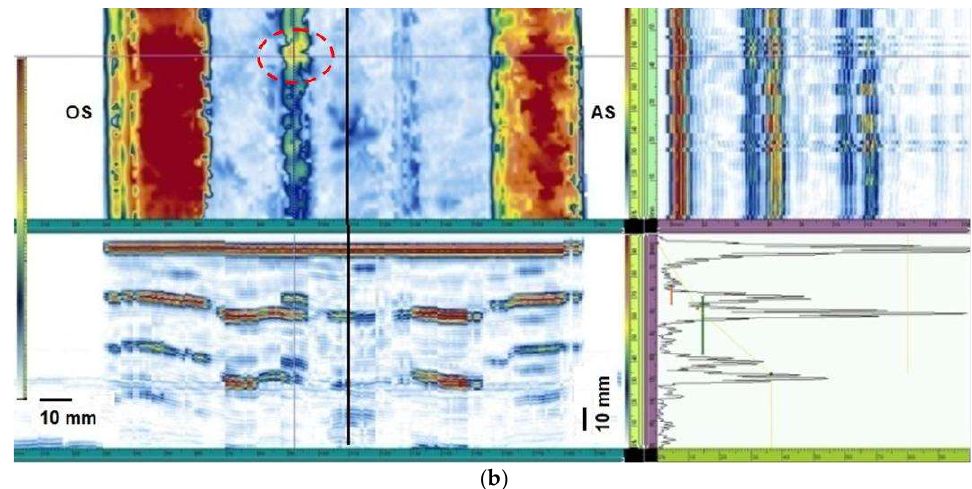
Figure 9. ( a ) Specimen 3 after delamination fracture; ( b ) ultrasonic testing (UT) images before the breaking; the red circle shows an irregular defected area.